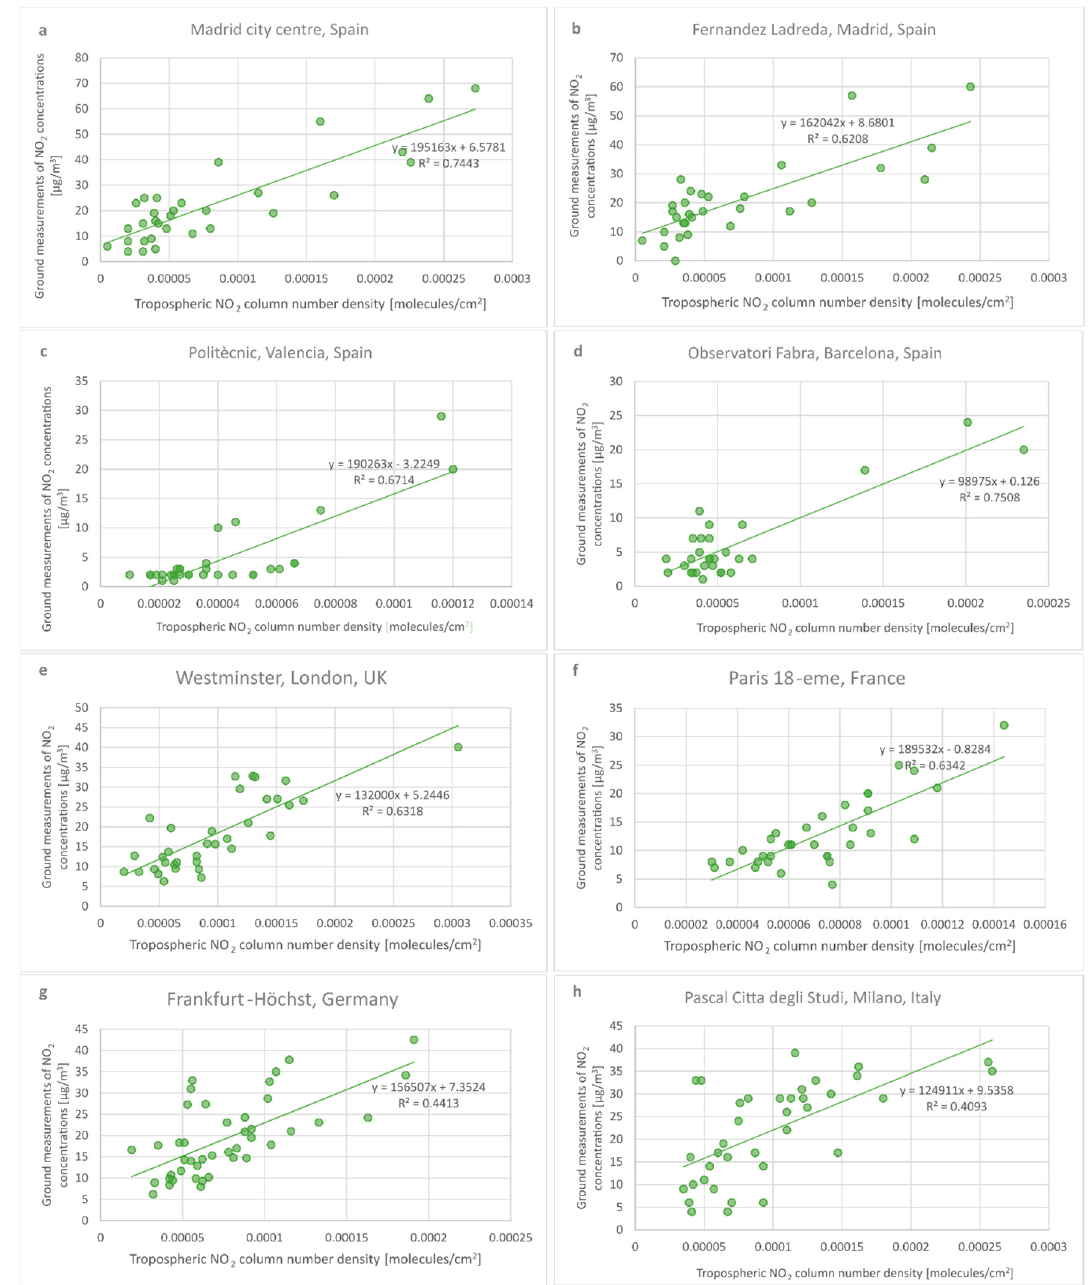
Figure 10. Data correlation between satellite-based tropospheric NO 2 column number density derived from TROPOMI (S-5P) L3 products and ground-based measurements of NO 2 concentrations for various European cities as follows: Madrid City Center ( a ); Fernandez Ladreda Station, Madrid ( b ); Valencia, Spain ( c ); Barcelona, Spain ( d ); London, UK ( e ); Paris, France ( f ); Frankfurt, Germany ( g ); Milano, Italy ( h ).